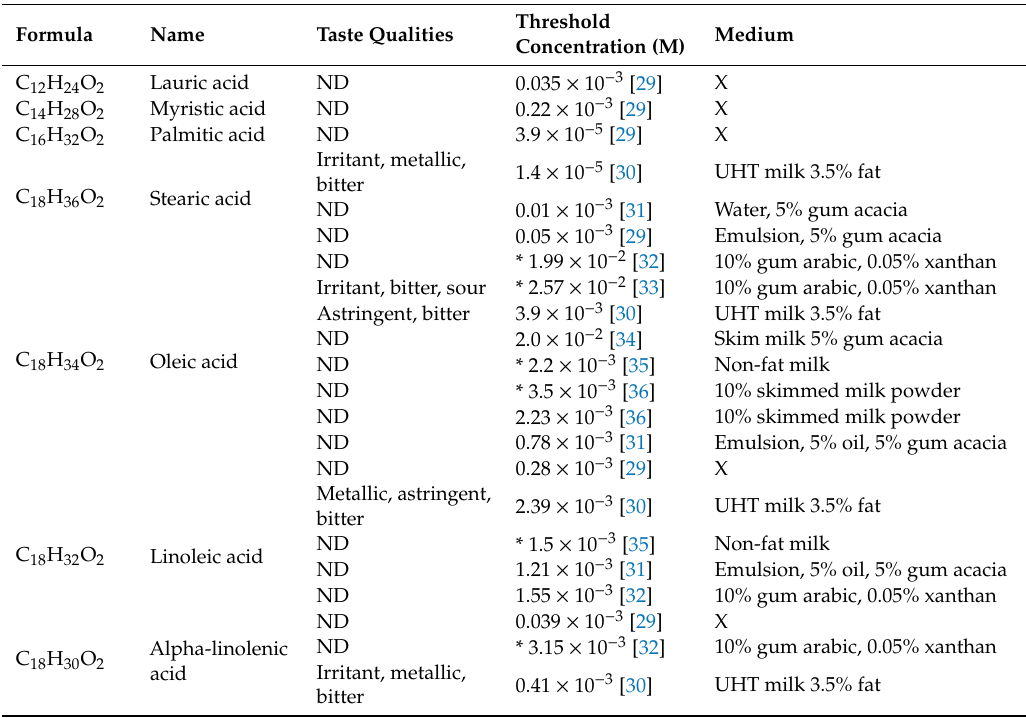
Table 3. Taste qualities and threshold concentration of fatty acids in di ff erent medium with or without